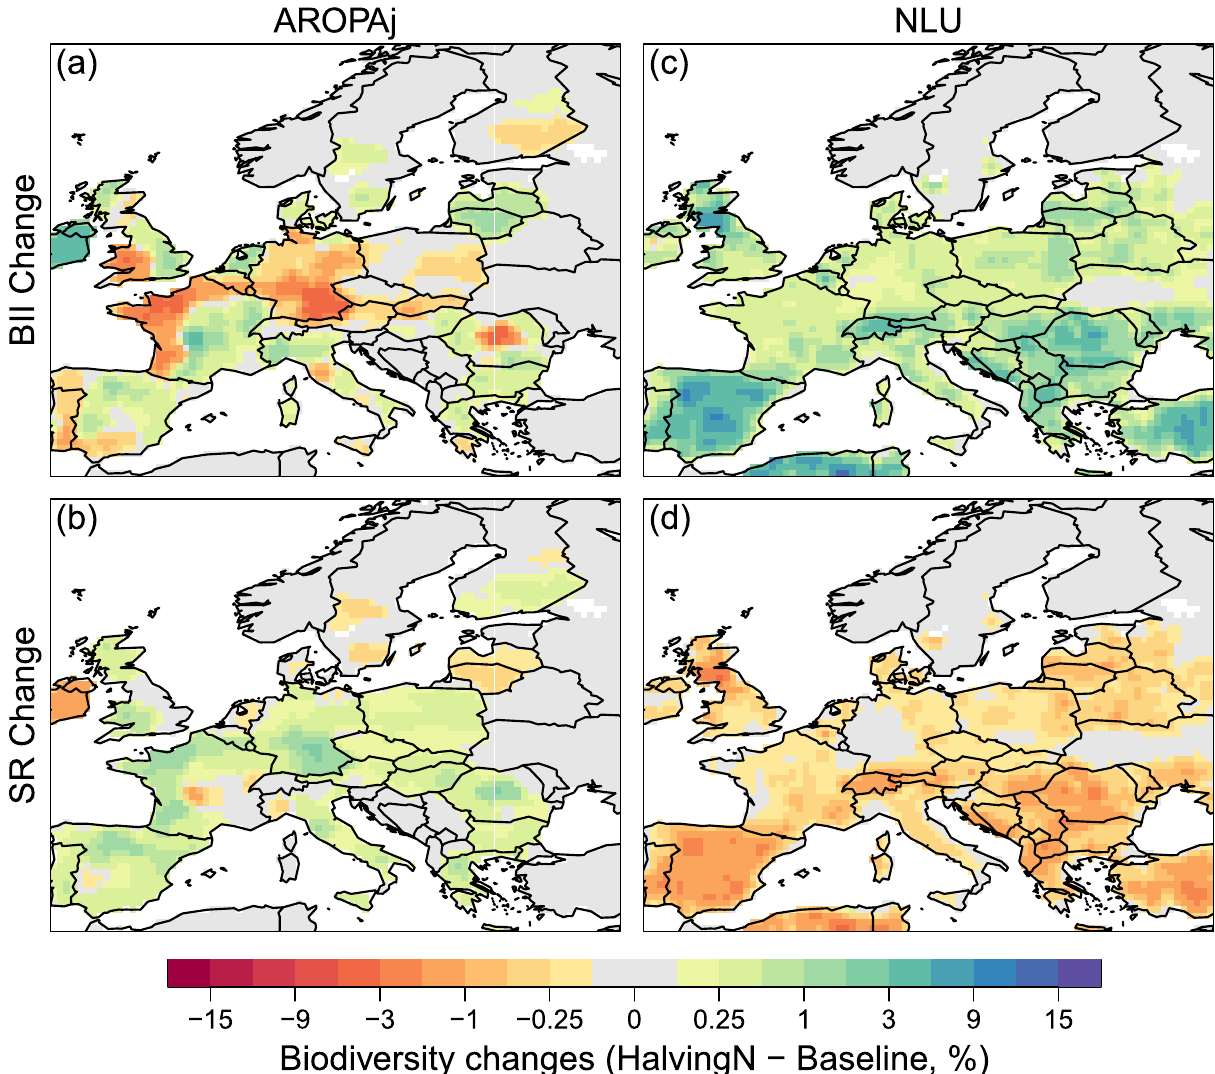
Figure 3. Biodiversity Intactness Index (BII) and Species Richness (SR) changes across the EU as computed by the PREDICTS models for the AROPAj ( a , b ) and NLU ( c , d ) land-use change scenarios. The changes are calculated as differences between the Halving-N and Baseline simulations. BII indicates average abundance of a taxonomically and ecologically broad set of species in an area relative to their abundances in an intact reference ecosystem. The SR reports the number of species, relative to the number expected in a natural system. This figure is created using software R version 3.6.0 (https:// www.r- proje ct.